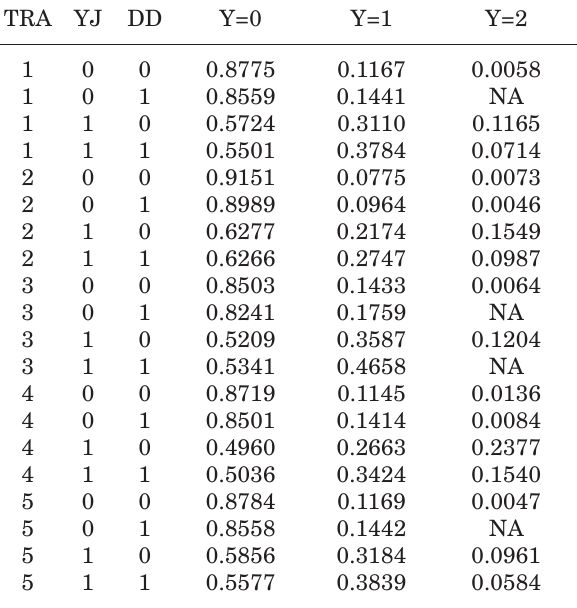
Table 3. Conditional probability of symptom expression. The first 3 columns on the right show the field-state of a plant in a given year and the last 3 the probability of observing the value y of Y in the next year. The symbol NA is used to indicate cells that showed sampling zeros. Transitions from YJ = 2 to Y were removed from the Table because no transition is possible for dead